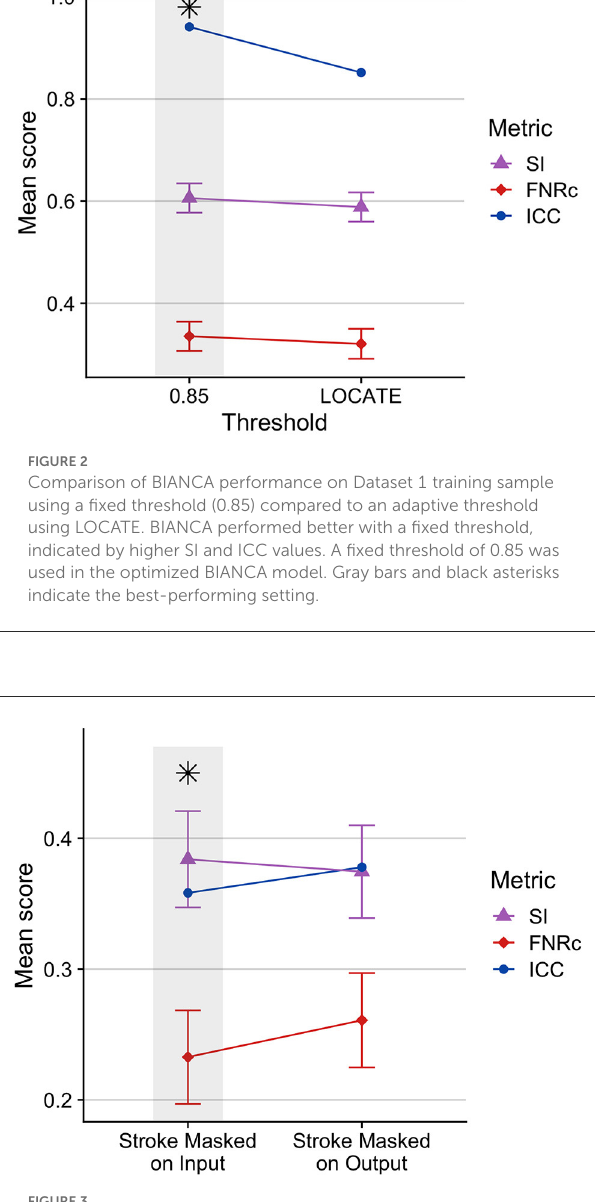
FIGURE3 Comparison of BIANCA performance when stroke lesion was removed from BIANCA input or output. BIANCA performance was improved when stroke lesions were masked in training input. This testing phase was performed prior to BIANCA optimization to determine the best starting point for BIANCA model testing (default BIANCA parameters). Gray bars and black asterisks indicate the best-performing setting.